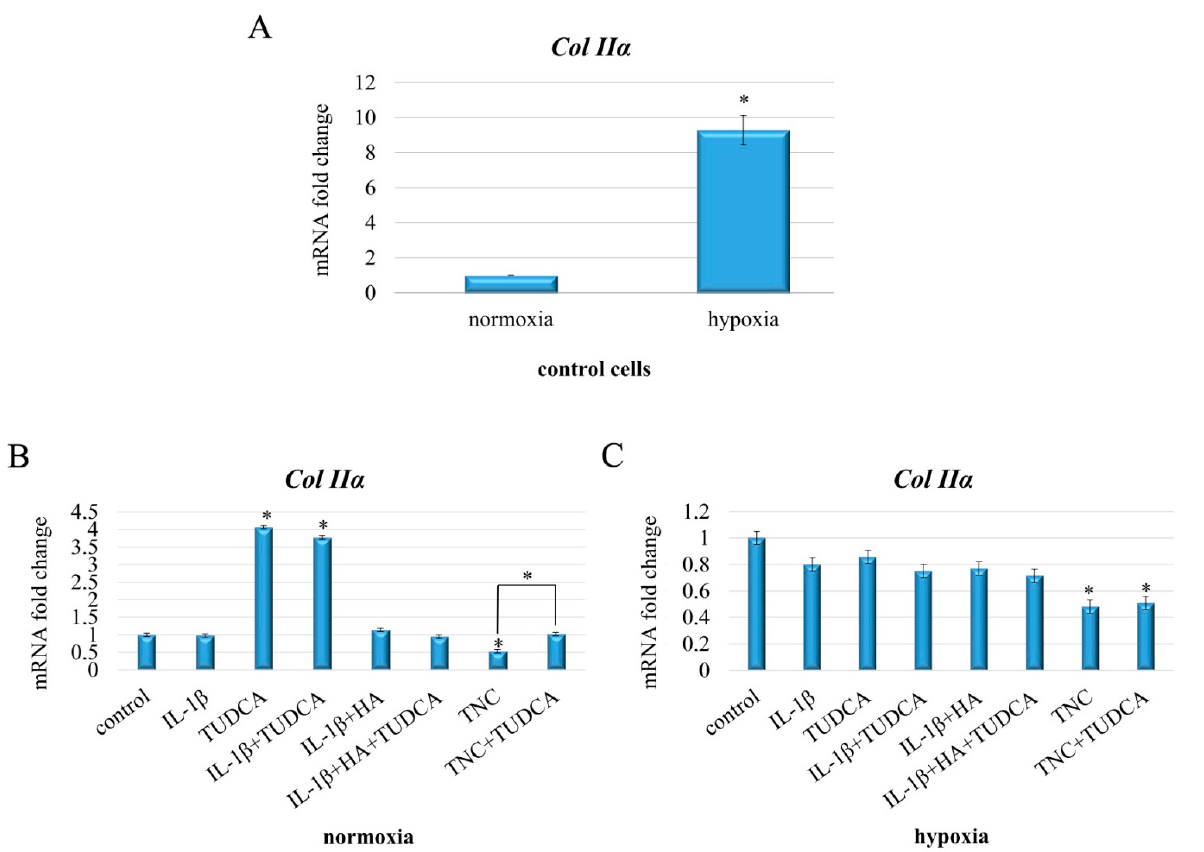
Figure 6. Expression of type II collagen evaluated in NHAC-kn chondrocyte cells stimulated with IL-1 β , TUDCA, IL- 1 β +TUDCA, IL-1 β +HA, IL-1 β +HA+TUDCA, TNC, and TNC+TUDCA for 72 h. Relative quantification of Col II α expression in normoxic vs. hypoxic control cells ( A ). Relative quantification of Col II α expression in cells subjected to indicated treat- ments in normoxic ( B ) and hypoxic ( C ) conditions. Results of qPCR analysis are presented as mean ± SD from three inde- pendent experiments run in triplicate. Significant changes are expressed relative to controls and marked with asterisks and hashes placed above the columns, or as specifically indicated with dashes linking compared treatments. Statistical significance was considered if * p < 0.05.